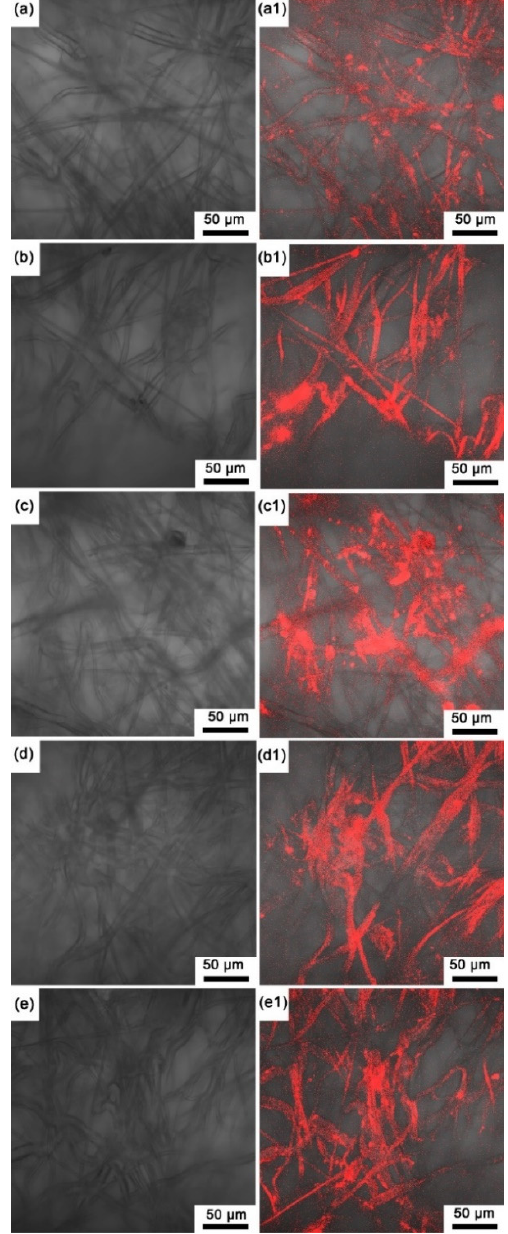
Figure 3. ( a ) The optical image of the sensing film (SF-EC) with a diameter of 5 mm; ( b ) side view of the sensing film (SF-EC) with a thickness of 160 μ m.